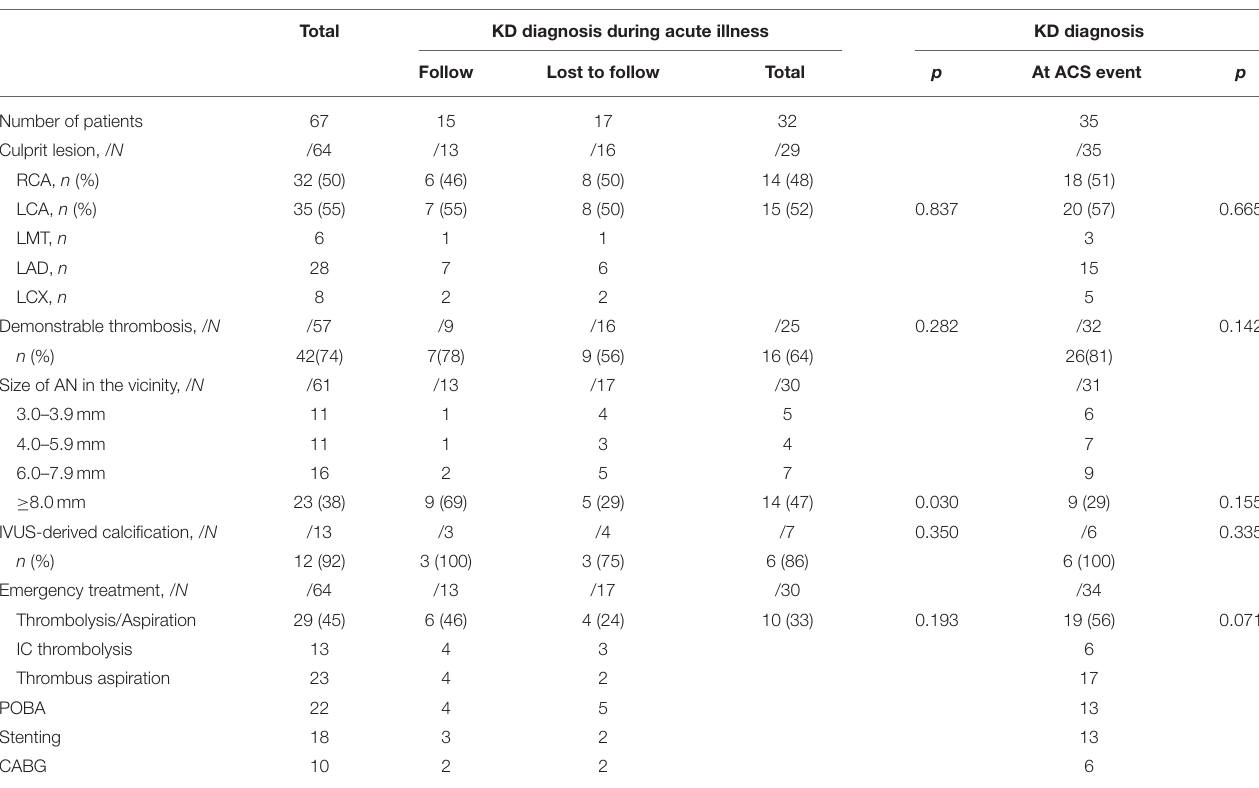
TABLE 2 | Characteristics of the culprit lesions.